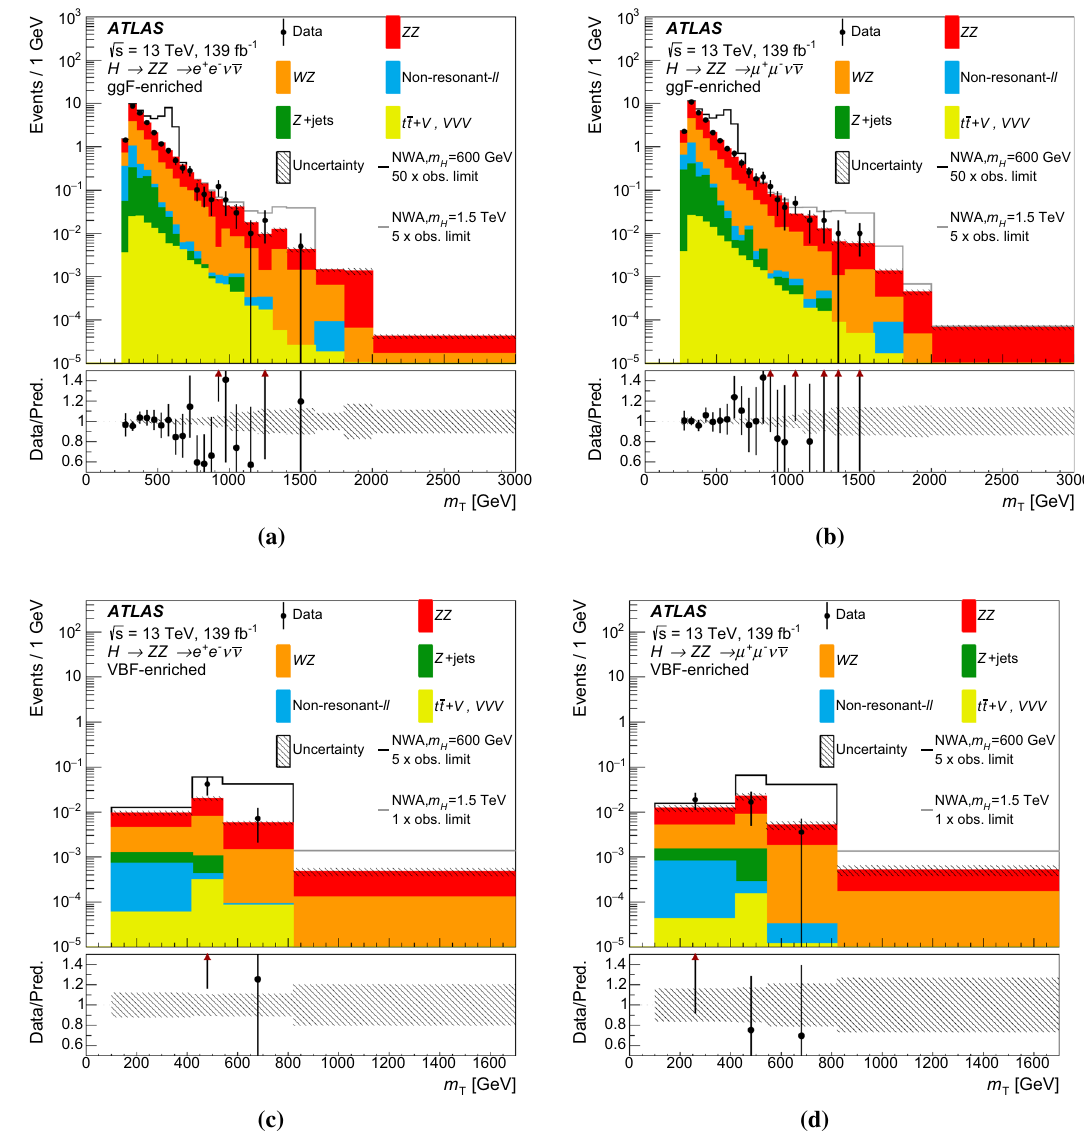
Fig. 3 The m T distribution in the (cid:3) + (cid:3) − ν ¯ ν search for a , b the ggF cat- egories and c , d the VBF categories. Events beyond the upper limit of the histogram are included in the last bin of the distribution. The back- grounds are determined from a combined likelihood fit to data under the background-only hypothesis. The simulated m H = 600 GeV (1 . 5 TeV) signals are normalised to a cross section corresponding to 50 (5) times the observed limit given in Sect. 9.1.1 for the ggF production mode and the recent measurements of the SM Higgs boson properties [99]. The white regions in the exclusion plots indicate regions of parameter space which are not excluded by the present analysis. In these regions the cross section predicted by the 2HDM is below the observed cross-section limit. In compar- ison with the previous publication, the excluded regions are significantly expanded. For example, in the tan β versus m H plane for the Type-II 2HDM the excluded region in tan β is more than 60% larger for 200 < m H < 400